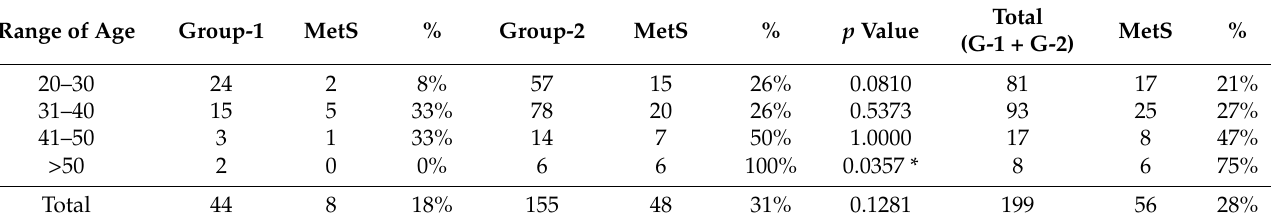
Table 4. Metabolic syndrome among naïve and HAART patients by age ( n = 199).